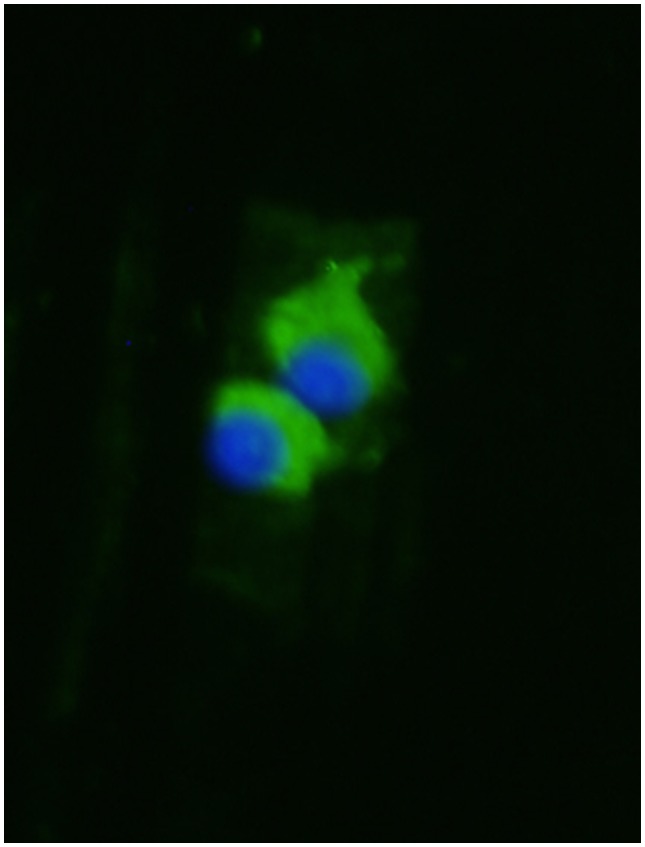
Podocyturia assay.Hoechst nuclear staining (blue); podocin antibody followed by a secondary fluorescein isothiocyanate-labeled antibody (green).